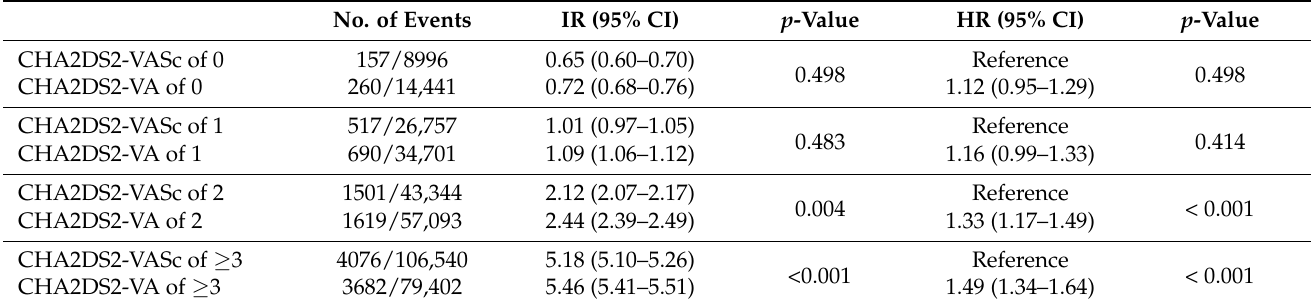
Table 3. Risk of ischemic stroke in AF patients stratified by the CHA2DS2-VASc and CHA2DS2-VA